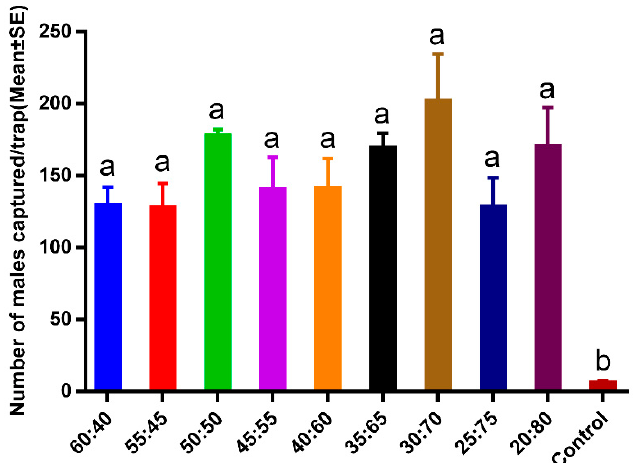
Figure 2. Trap catches of Ectropis grisescens male moths with different sex pheromone ratios. Bars mean standard error. Different letters indicate significant difference (Tukey’s honestly significant difference (HSD) test, p < 0.05).